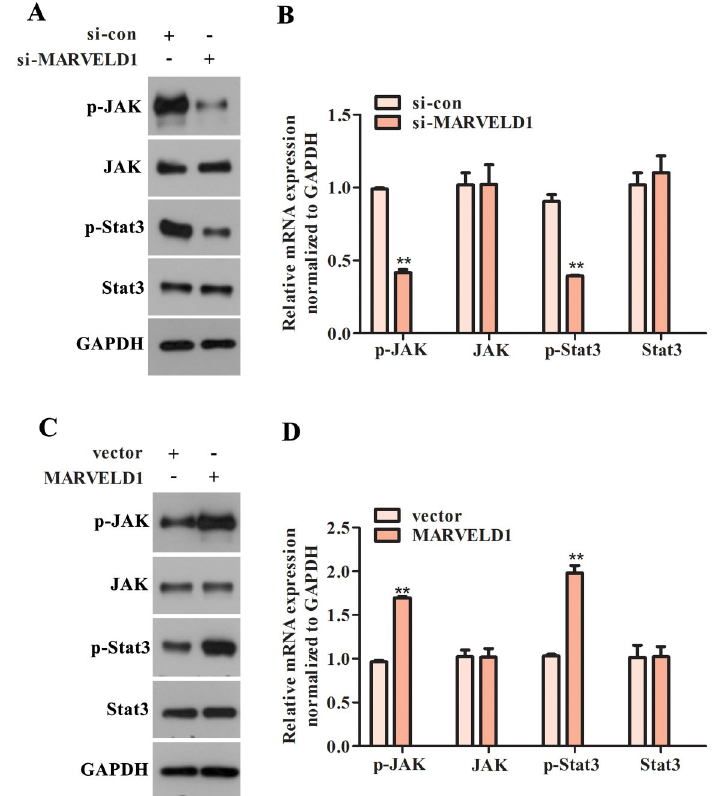
Figure 7. Western blot assay was performed to measure the expression levels of JAK/STAT pathway-related factors in ( A and B ) U251 cells transfected with si-MARVELD1 (**P o 0.01 vs si-con group) and ( C and D ) U87 cells transfected with pcDNA3.1-MARVELD1. Data are reported as means ± SD. **P o 0.01 vs vector group (Student ’ s t